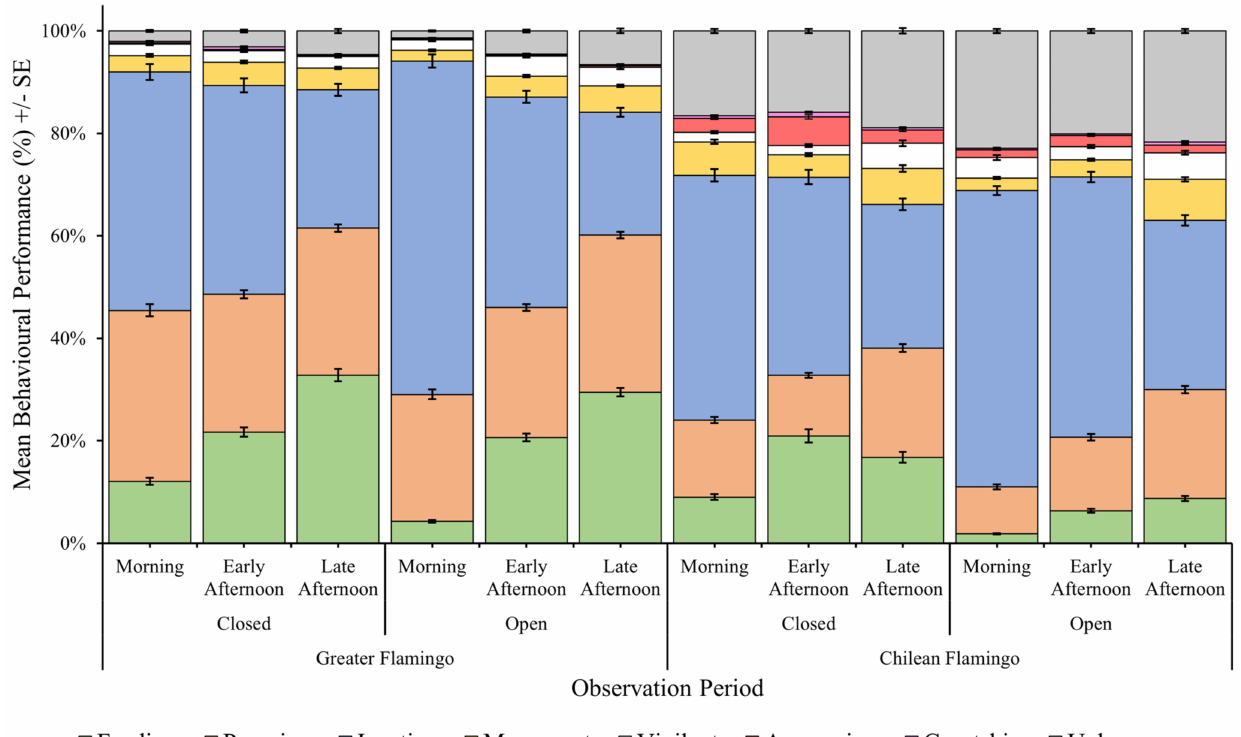
Figure 2. Average time-activity budgets of Greater and Chilean Flamingo flocks across observation periods of zoo status. Error bars represent the variation (SE ± ) in mean performance of behaviours. Greater Flamingos spent most of their time inactive, preening, and feeding. Chilean Flamingos spent most of their time inactive, preening, feeding, or their behaviour was unknown. Feeding decreased and inactivity increased in the Chilean Flamingo flock when the zoo